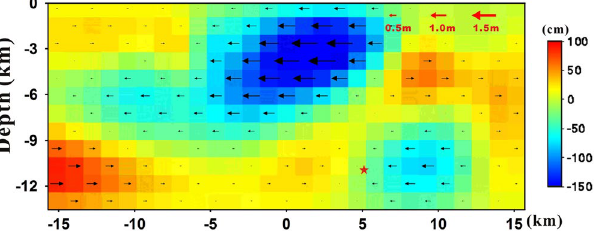
Figure 7. Slip distributions along the fault plane during the South Napa earthquake derived from InSAR-based 3D modelling. Red star represents the hypocentre of the South Napa